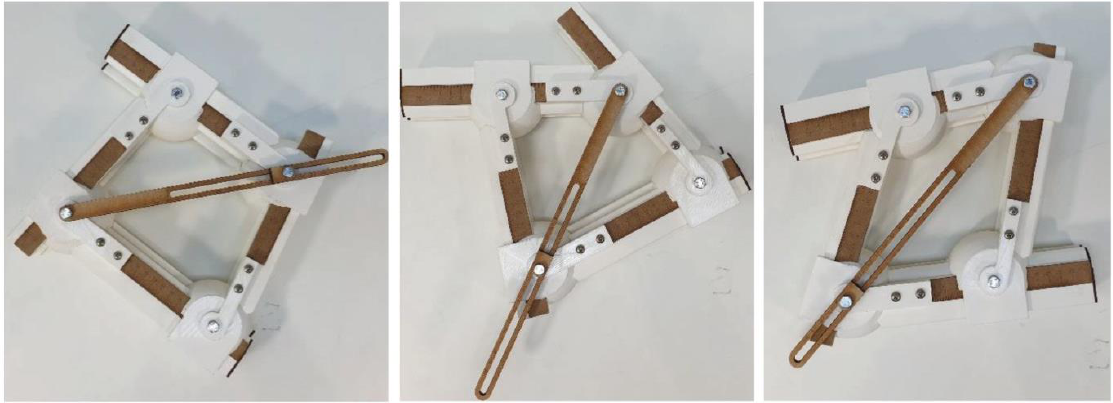
Fig. 16 Prototype of the adjustable mould in three different configurations.